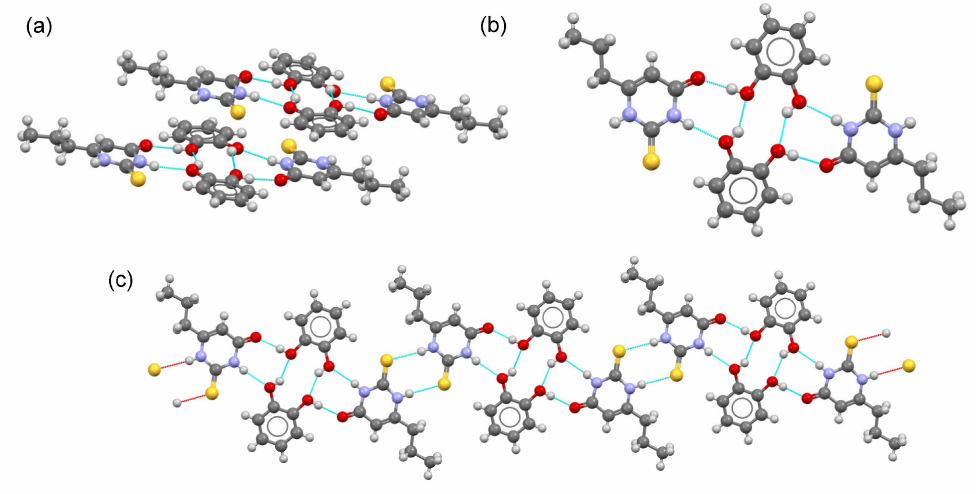
Figure 2. Schematic representation of the conformation of the side chain of PTU in the cocrystals reported in this work and in the parent PTU molecule.